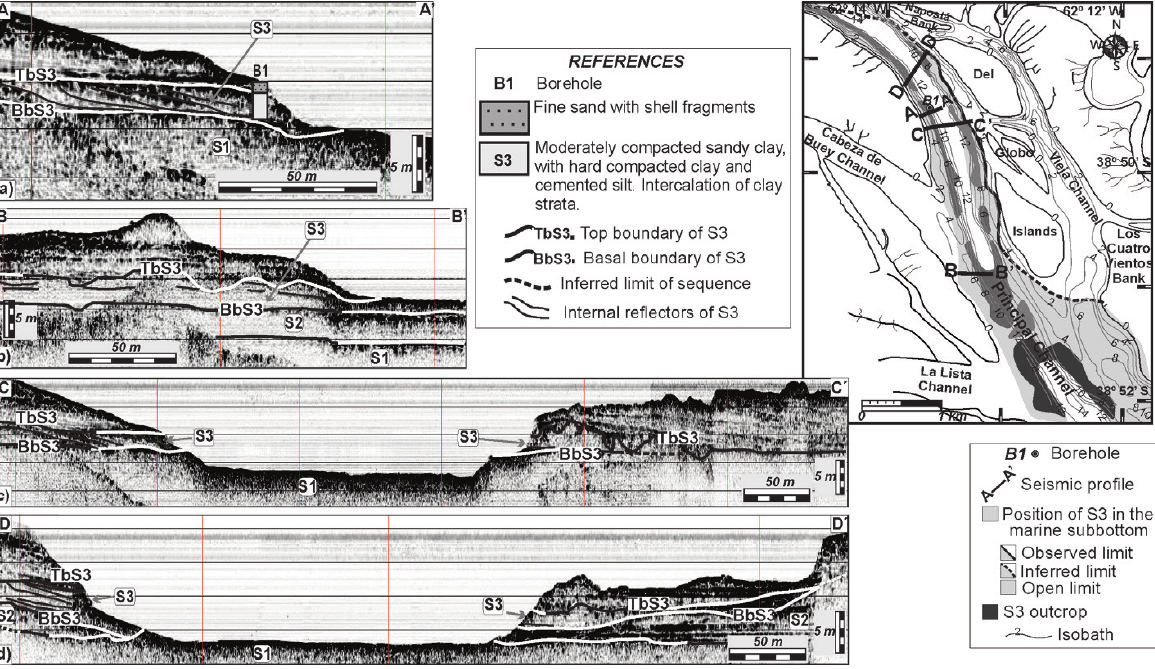
Fig. 3 - Seismic sequence S3. 3.5-kHz profiles showing stratigraphic features. Areal distribution of S3 in the marine subbottom and lithological data